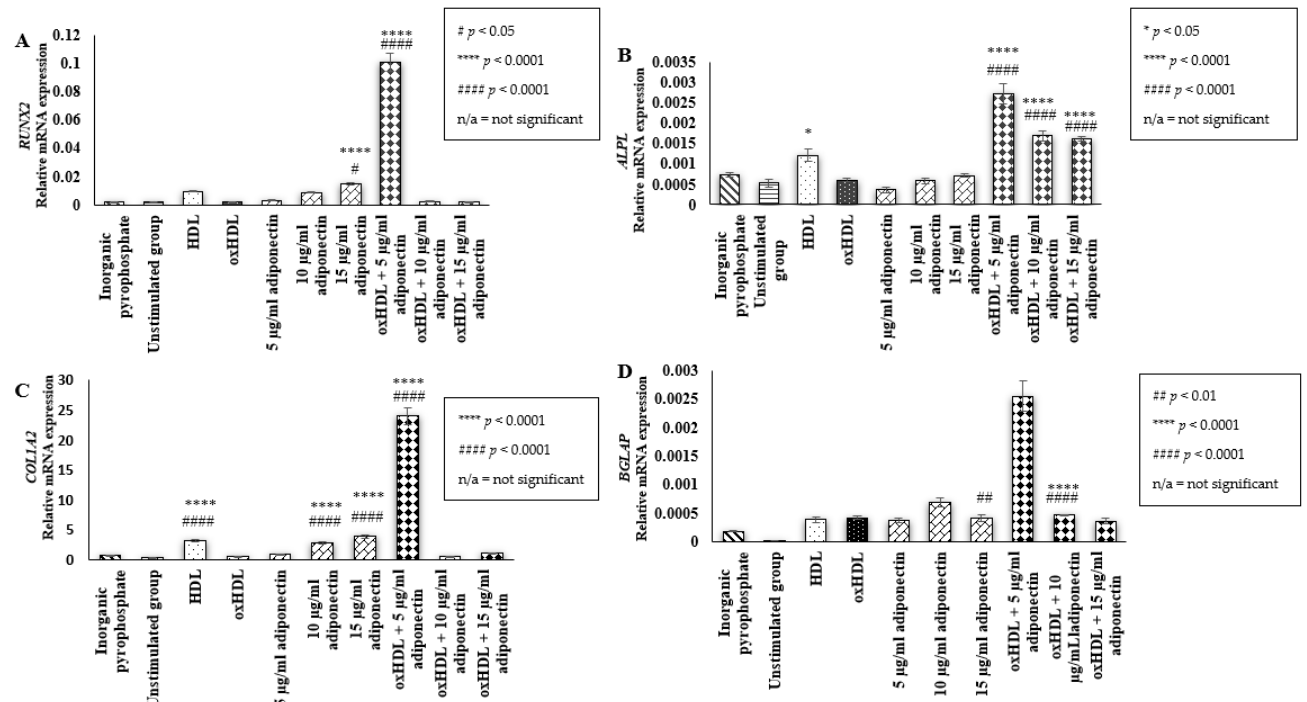
Figure 2. Effects on bone-associated markers in HOBs. Effects of (i) inorganic pyrophosphate (posi- tive control), (ii) culture medium (negative controls, denoted as the unstimulated group), (iii) HDL (100 µg/mL protein), (iv) oxHDL (100 µg/mL protein), (v) adiponectin (5, 10, and 15 µg/mL), and (vi) the c ombination of oxHDL (100 µg/mL) with adiponectin (5, 10 , and 15 µg/mL) on mRNA gene expression of ( A ). RUNX2, ( B ). ALPL, ( C ). COL1A2, and ( D ). BGLAP in HOBs. Data are expressed as the m ean ± SEM of 3 experiments. * p < 0.05, **** p < 0.0001, # p < 0.05, ## p < 0.01, #### p < 0.0001. Non-available (n/a) indicates not significant. * Indicates the comparison with the oxHDL group; # Indicates the comparison with the unstimulated group. GAPDH and HPRT1 genes were used as the reference gene.